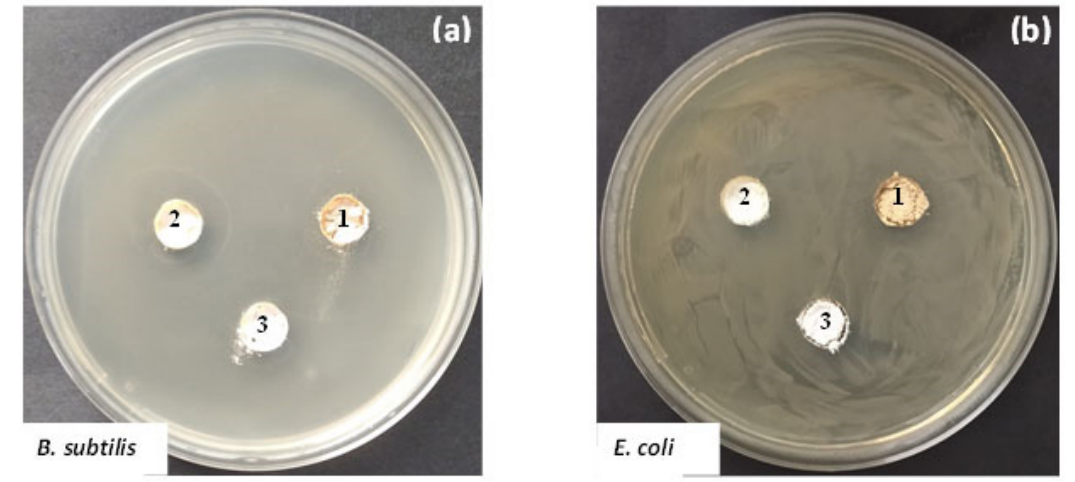
Figure 10. Antibacterial properties of samples TiO 2 /2% Nd (1), TiO 2 /2% Sm (2) and.pure TiO 2 (3) obtained by metal alkoxide against B. subtilis NBIMCC 3562 ( a ) and E. coli NBIMCC K12 ( b ).